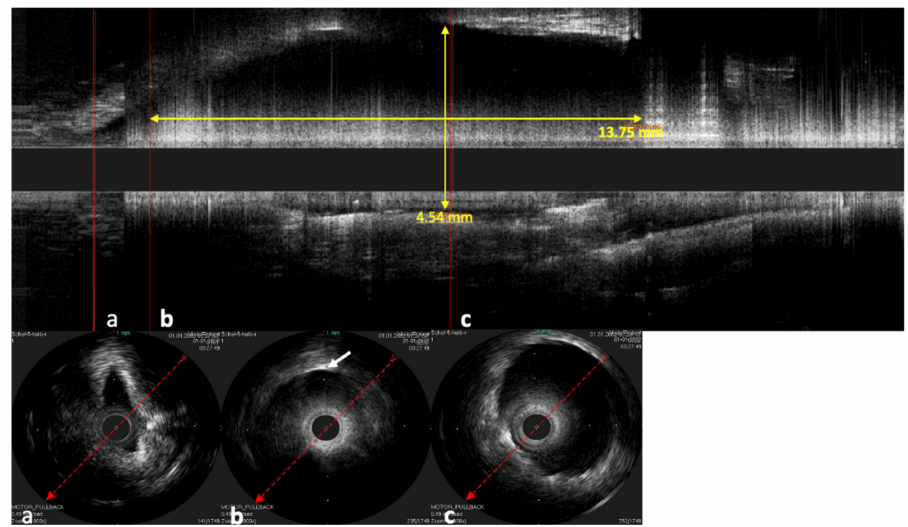
Figure 8. Sonographic image of the stented ET, performed with the Refinity ST probe. The upper image shows the longitudinal view of the scan. Parts ( a – c ) show the respective cross-sections of the scans. Part ( a ) shows the area in front of the stent, where the tubal lumen widens toward the stent. Part ( b ) shows the initial area of the stent where the first stent strut can be seen sonographically (indicated by white arrow). Part ( c ) shows the cross-section in the middle section of the stent. The cross-section here was measured to be 4.54 mm. In the longitudinal view, a length of 13.57 mm was measured.